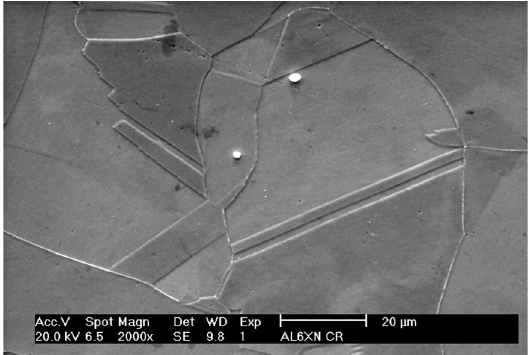
Figure 7 . SEM image of the microstructure of the AL-6XN PLUS™ super austenitic stainless steel.